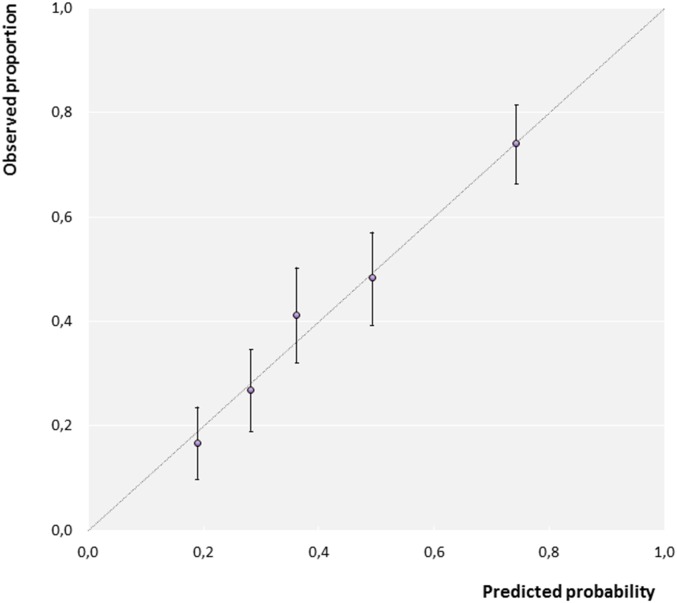
Calibration plot of calculated probabilities of group A streptococcus (GAS) and observed outcomes (N = 676).Circles represent mean calculated probabilities versus observed proportions in subgroups defined by quintiles of the calculated GAS probabilities (m = 1). Vertical bars are 95% confidence intervals. Dashed diagonal line represents perfect calibration.